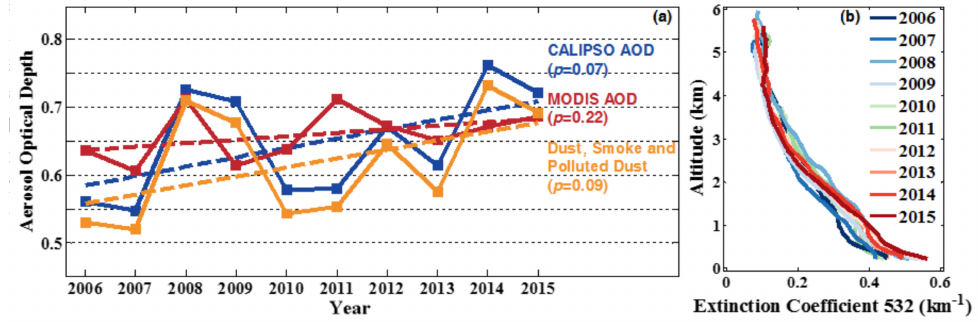
Figure 1. Temporal variations in spatial average AOD from ( a ) CALIPSO and MODIS during the monsoon season and ( b ) the vertical average aerosol extinction coefficient at 532 nm in South Asia from 2006 to 2015, respectively. The dashed lines indicate the linear fit line of the solid line with the same color; p is the significance